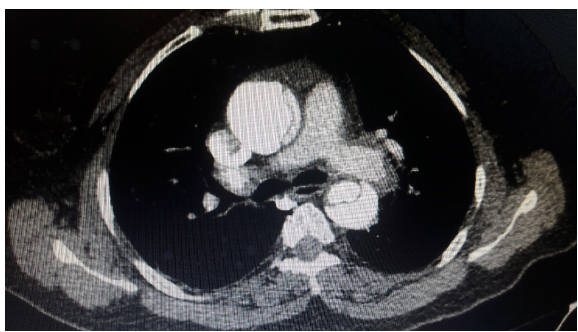
Figure 4. Crescent Sign in Non-contrast CT-Scan. Note . CT: Computed tomography.